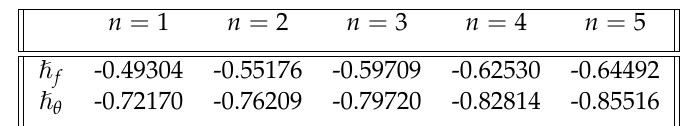
Table 2. Selection of (cid:125) f and (cid:125) θ